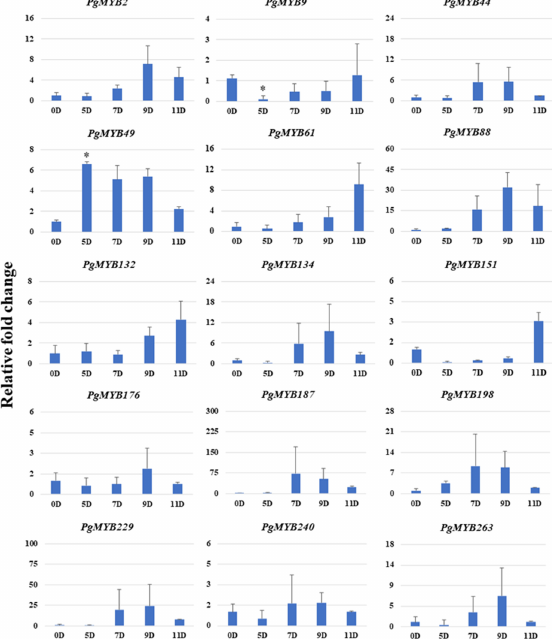
Figure 6. Relative expression analysis of PgMYB genes under dehydration stress at 0th day, 5th day, 7th day, 9th day and 11th day time points. The X -axis represents different time points and the Y -axis indicates relative expression level. Significant difference in mean indicated by * p < 0.05 as obtained by Student’s t-test.